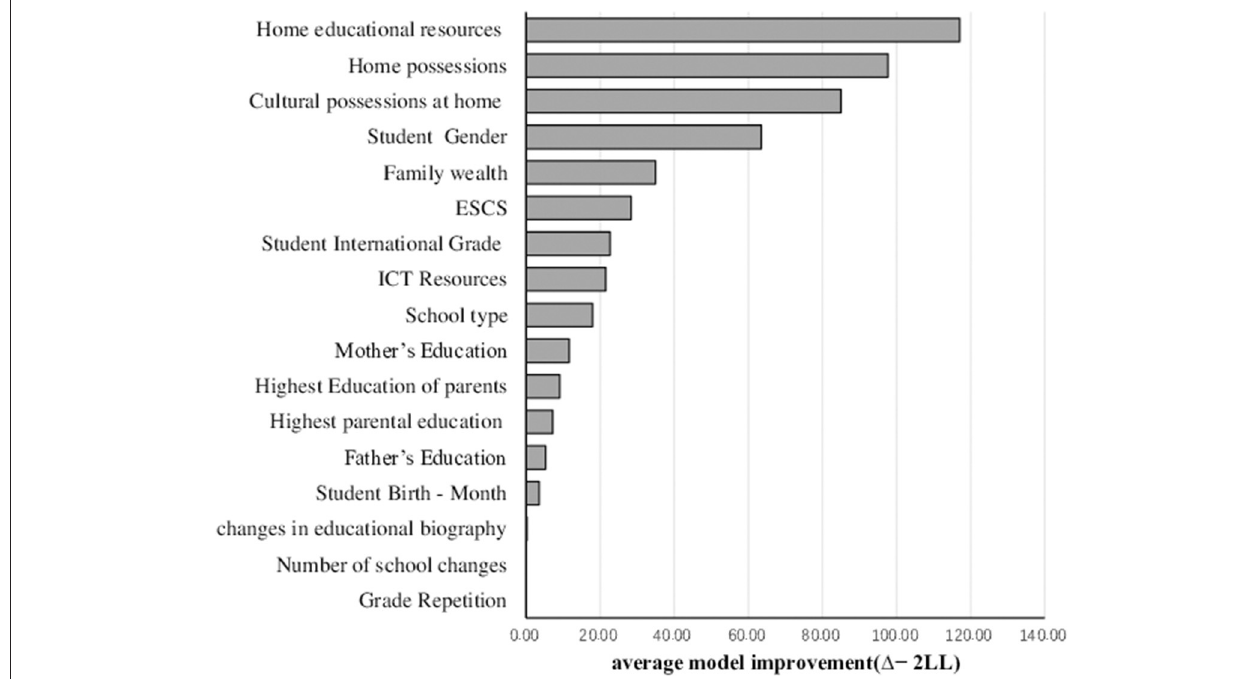
2 LL ) between the overall model and the −